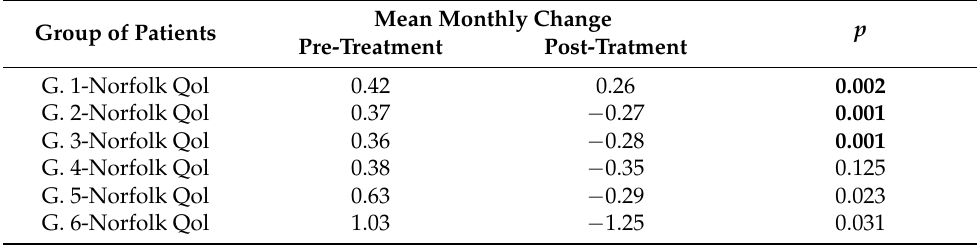
Table 3. Norfolk QoL statistical analysis